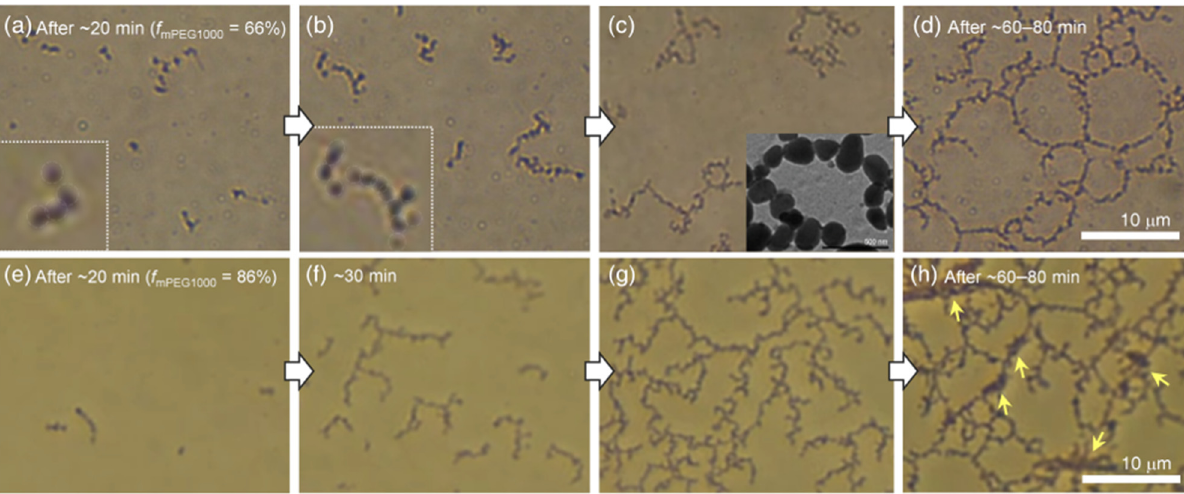
Figure 3. Snapshot optical microscopy (OM) images showing the morphological growth processes of mPEG1000:Bu mixed systems at the air–liquid interface. f mPEG1000 = ( a – d ) 66% and ( e – h ) 86%. ( a , e ) Short chains. ( b , f ) Relatively long and branched chains. The inset photograph in ( c ) is a TEM image of a necklace-like structure. ( d ) Interconnected structures formed by merging many necklace-like structures (see Movie S3). ( g , h ) Dendrimer-like structures were connected to form a giant interconnected structure. The black regions marked by the yellow arrows ( h ) correspond to densely packed SPs. The whole process took about 80–90 min under our experimental conditions (22–23 °C and 50–55% humidity).